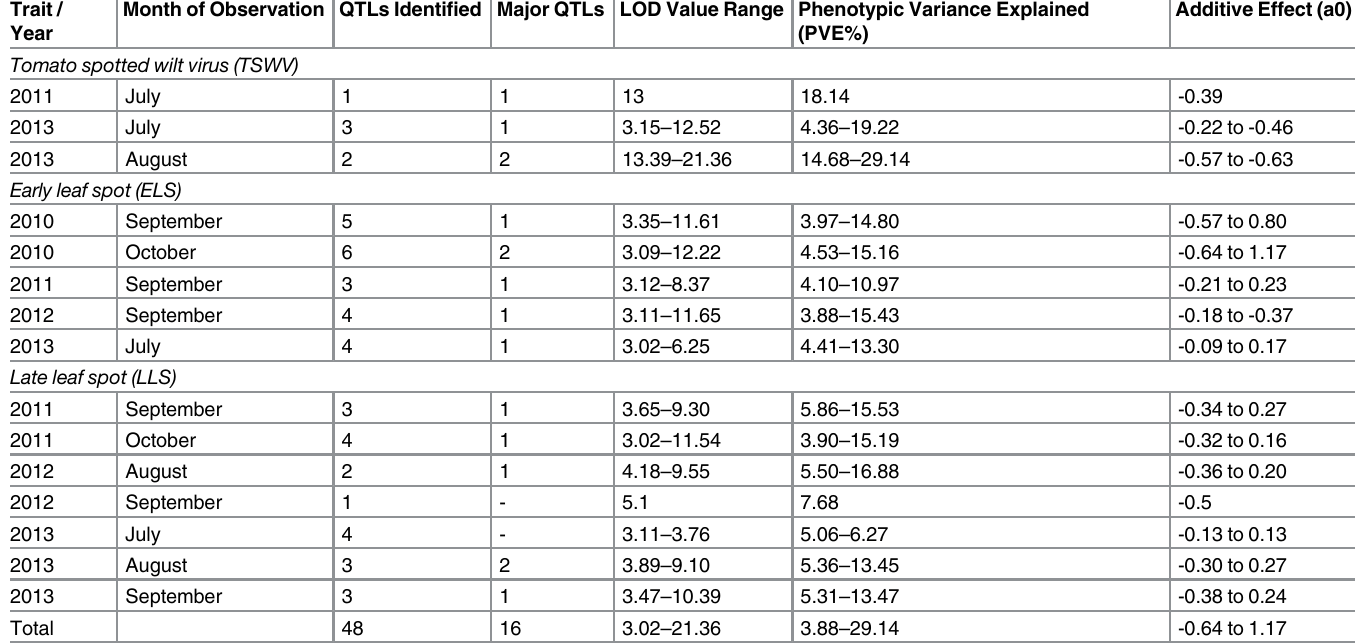
Table 2. Summary of QTLs identified in the S-population for resistance to TSWV, ELS and LLS. Trait /